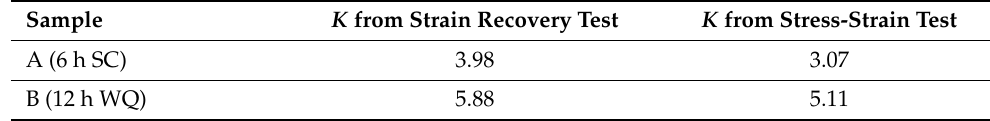
Table 1. Registered values for Clausius–Clapeyron coefficient K for samples A and B.